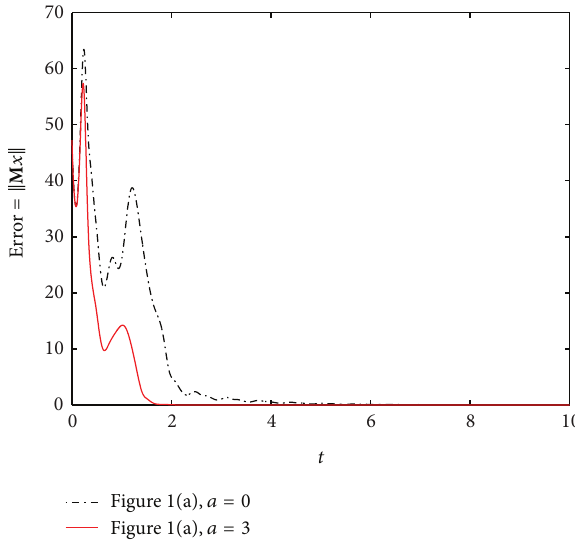
Figure 3: Exponential Synchronization errors ‖ M 𝑥‖ of the network in Figure